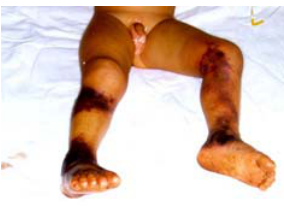
Figure 4: A severe accident with prominent bleeding (uncoagulable blood) caused by a Bothrops snake in a